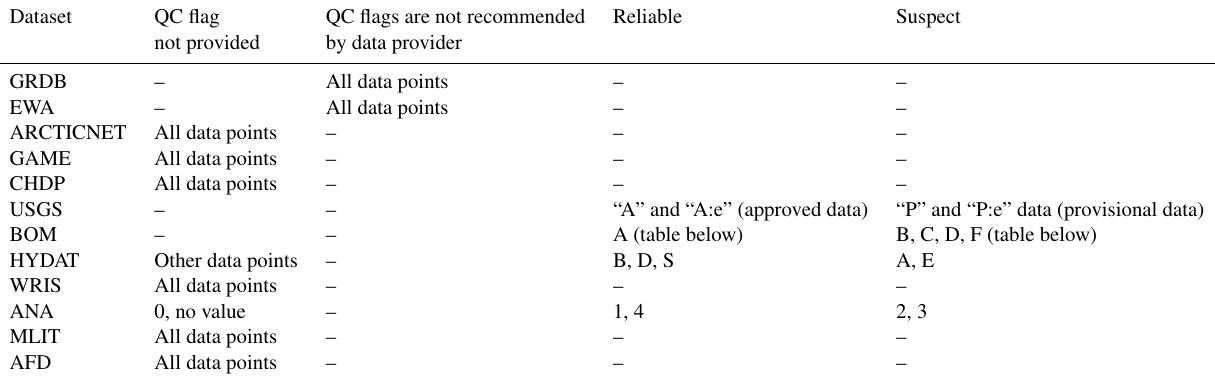
Table 2. Translation of daily quality control (QC) flags of the original databases (Table 1) to standardized values prior to the calculation of indices. Note that the Global Runoff Data Centre advises not to consider the QC flags in the GRDB and EWA files. Note also that some databases (HYDAT, ANA) do not provide QC flags for all daily